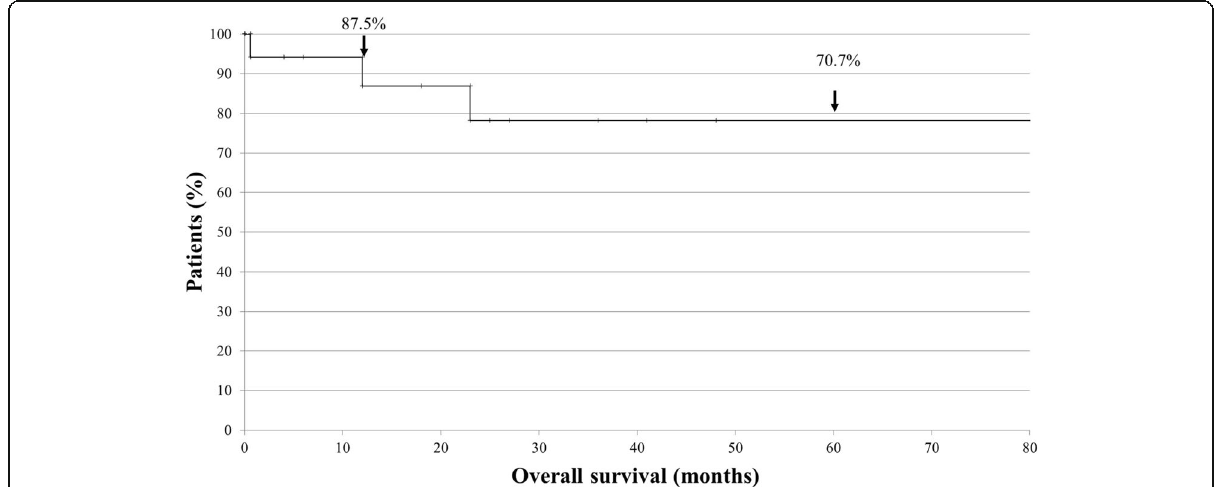
Fig. 6 Kaplan-Meier curves showing the overall survival of 16 patients with thyroid Burkitt ’ s lymphoma. The 12-month and 60-month overall survival rates were 87.5 and 70.7%,